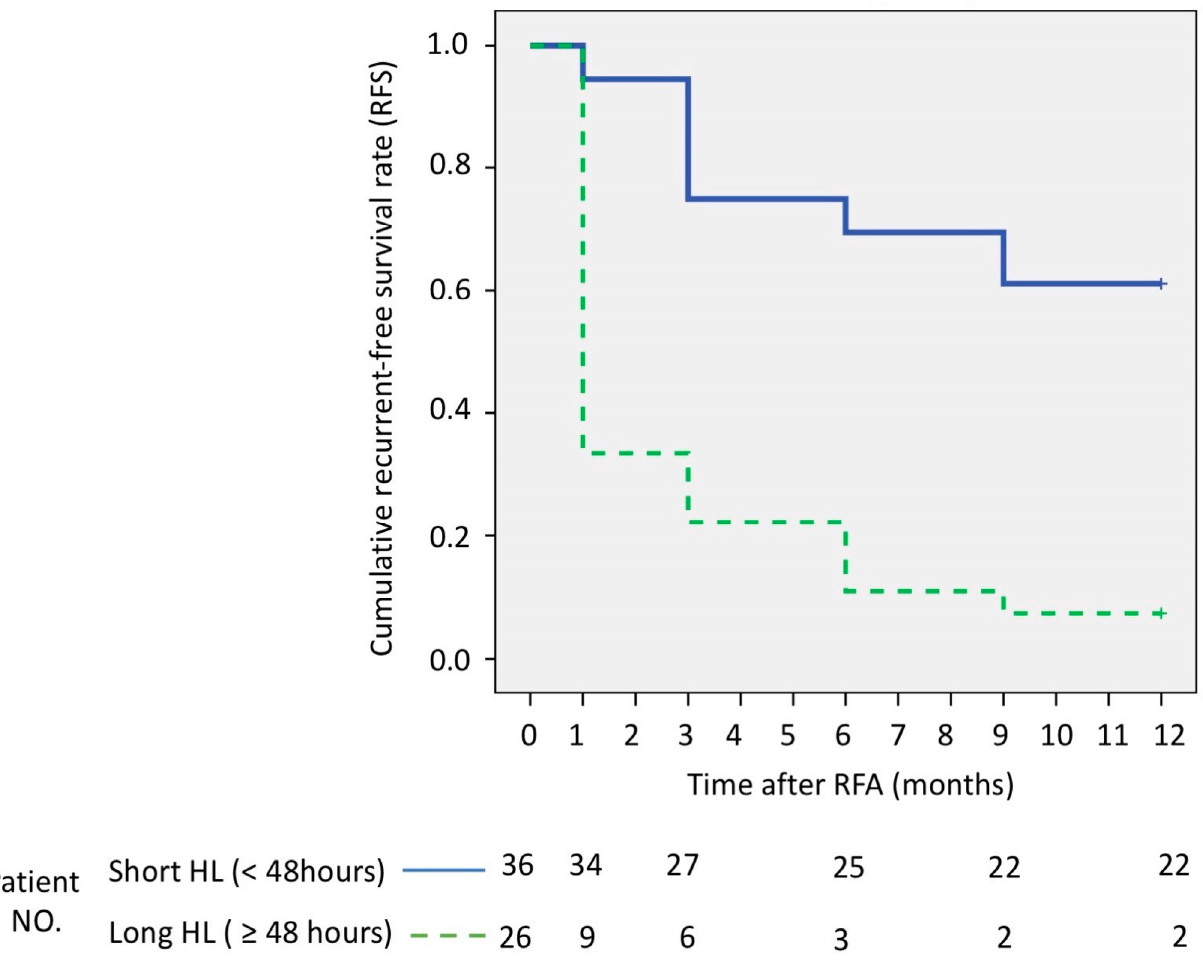
Figure 5. Comparisons of recurrent-free survival in 63 patients by half-life (HLs) of Des-gamma- carboxy prothrombin (DCP). Short HLs (< 48 h) n = 36 ; Long HLs ( ≥ 48 h) n = 26.